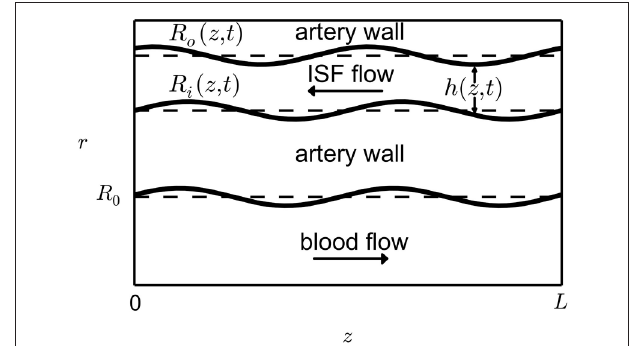
FIGURE 1 | Geometry of the perivascular drainage pathways model. The length L of a typical artery in the brain can be assumed to be much greater than the width W of the perivascular drainage pathways. Therefore we can approximate the flow as a lubrication model. The pulsation of the capillary is described by the function h ( z , t ).